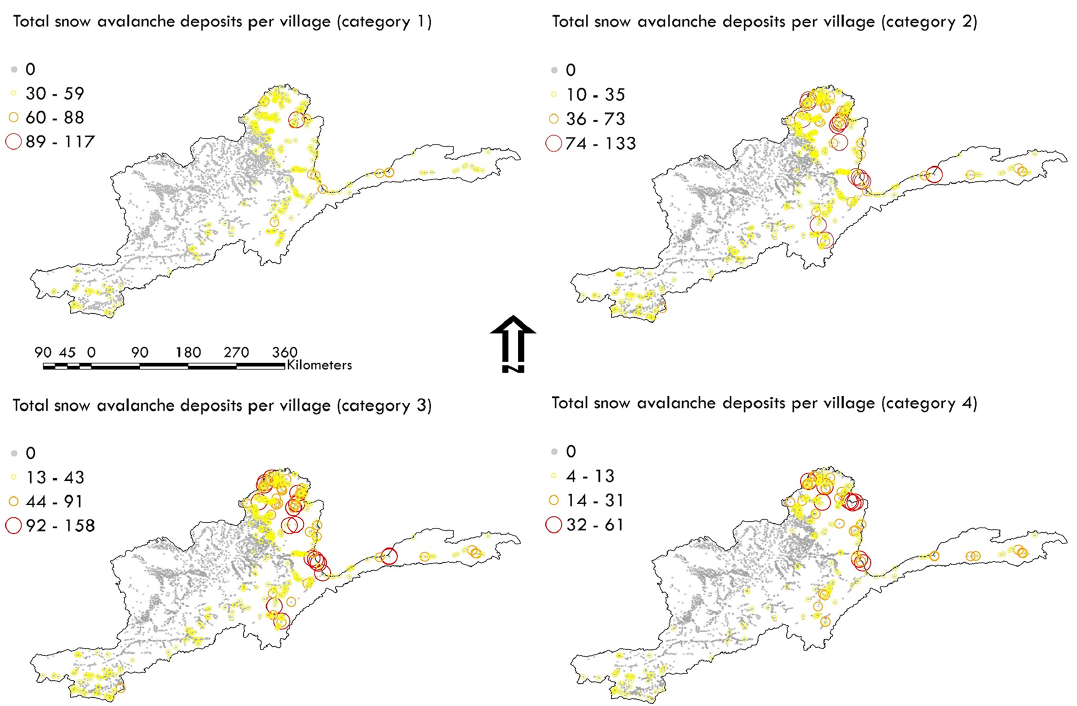
Figure 8. Total avalanche depositional zones per category and per village during the past 32